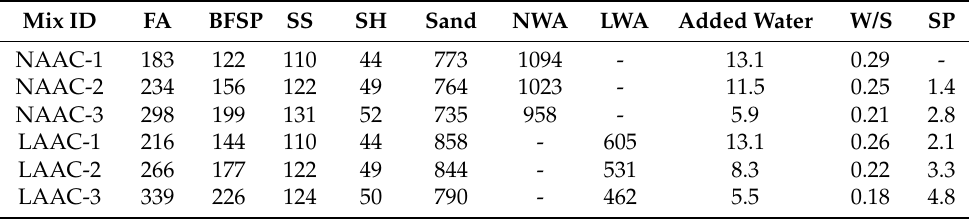
Table 4. Mixture proportions of the alkali-activated concretes (AACs) (kg/m 3